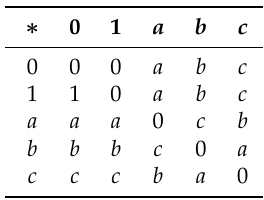
Table 6. Cayley table for the binary operation “ ∗ ”.